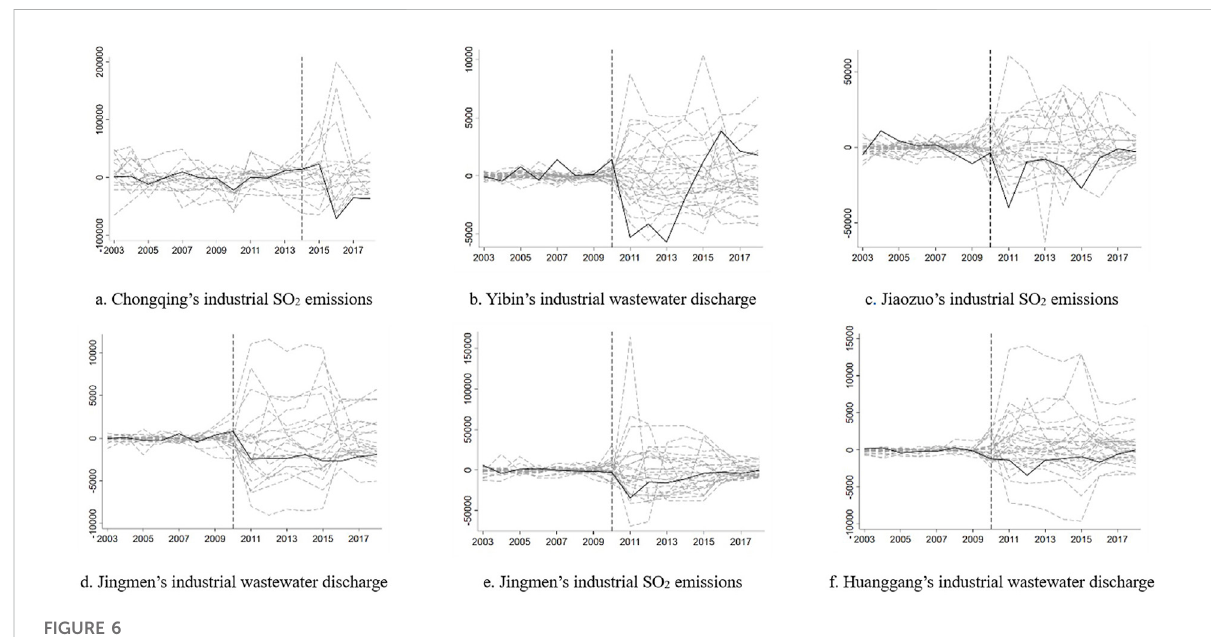
FIGURE 6 Permutation test